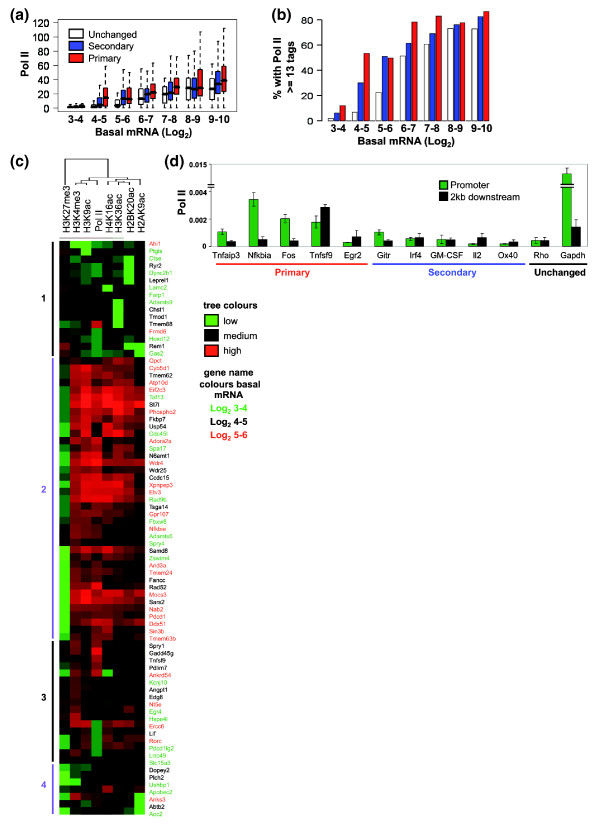
Inducible genes have higher RNA polymerase II occupancy at promoter regions. (a) Data from ChIP-Seq experiments with human CD4+ lymphocytes was used to determine the levels of Pol II at the promoters (-0.25 kb to +0.25 kb) of primary (red), secondary (blue) and unchanged (white) genes within each basal expression bin (Log2 robust multichip average values from expression profiling). The bar marks the median score, the edges of the boxes the second and third interquartile ranges and the whiskers the first and fourth interquartile ranges. (b) The percentage of promoters with tag counts equal to or greater than the median level (13) for the unchanged genes in the basal expression Log2 6 to 7 bin were plotted for each subgroup. (c) From the same data source the number of sequencing tags for H3K4me3 and H3K27me27, H3K9ac, H4K16ac, H2BK20ac, H2AK9ac and Pol II, overlapping -1 to +1 kb from the TSS, were counted for primary response genes with basal expression values between Log2 3 and 6. The logs of the sequence counts were median centered and normalized and heatmaps for the primary response genes were generated by uncentered correlation, complete linkage clustering. The major clusters are marked and the genes are colored according to their basal expression level (green, log2 3 to 4; black, log2 4 to 5; red, log2 5 to 6). In the cluster diagram, green indicates low tag counts and red indicates high tag counts. (d) ChIP assays were performed with antibodies against the CTD repeat of Pol II using unstimulated EL-4 T cells and detected by real-time PCR analysis. The data are presented as the ratio of immunoprecipitated DNA to the total input DNA and show Pol II occupancy at the promoter (green bars) and 2 kb downstream of the promoter (black bars). The mean and standard error of three independent experiments are shown.